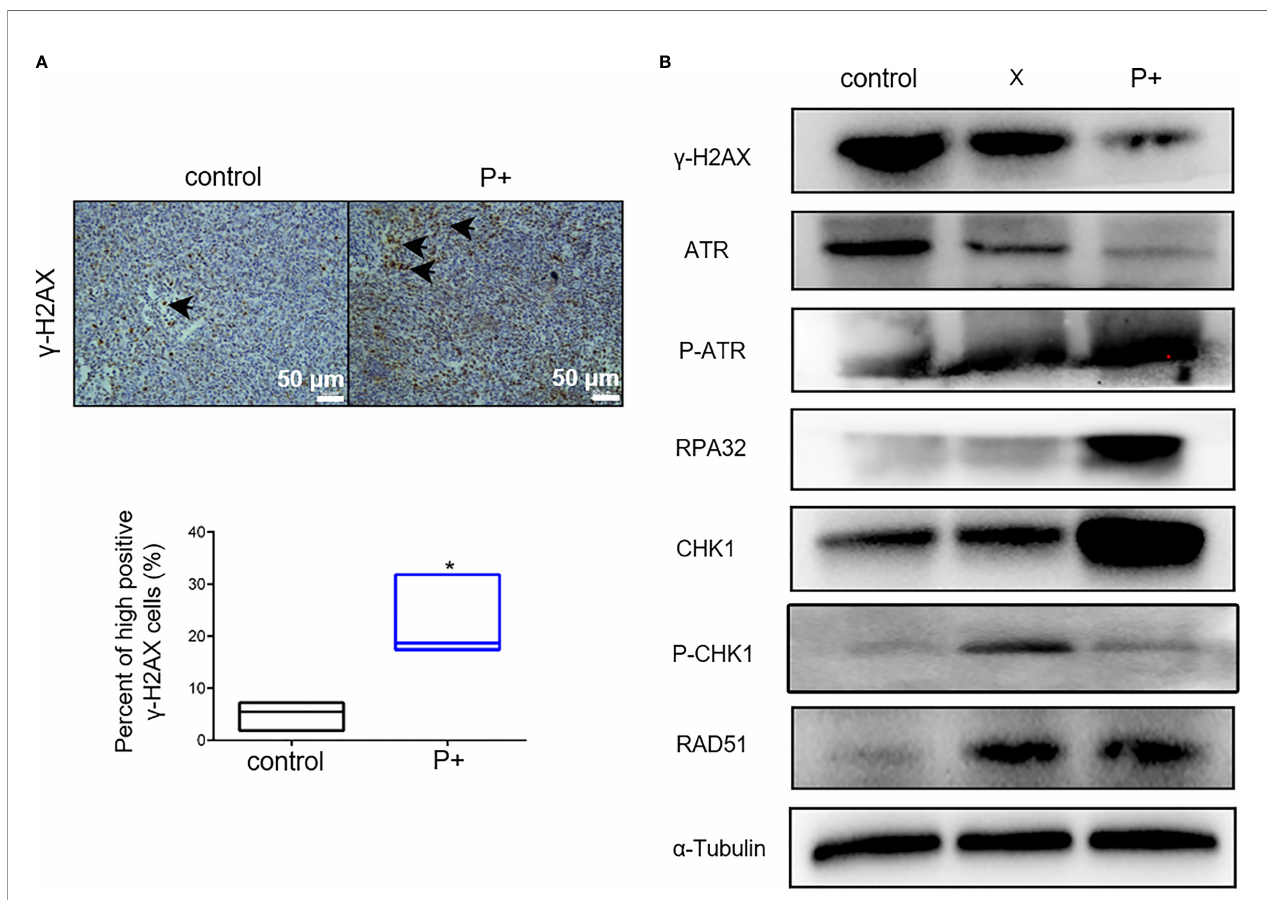
FIGURE 5 | The periodontitis-associated bacteria induce the ATR-CHK1-dependent DNA damage response in oral tumor-bearing mice. (A) The expression of g - H2AX in oral tumor-bearing mice was detected by immunohistochemistry. *p < 0.05. (B) The expression levels of g -H2AX, ATR, p-ATR, RPA32, CHK1, p-CHK1, RAD51, and a -Tubulin in tumor tissues were performed in Western